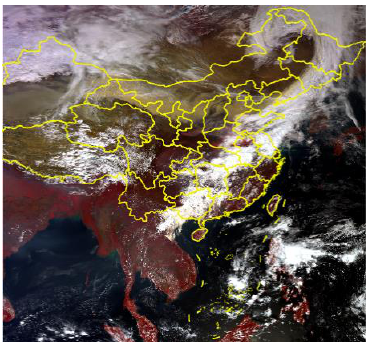
Figure 2 . Study area (Himawari-8 geostationary meteorological satellite false color